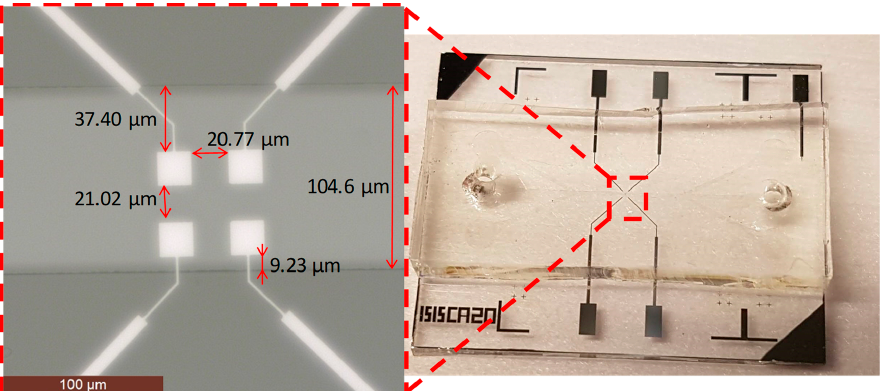
Figure 10. Image of the electrodes with their dimensions and spacing.